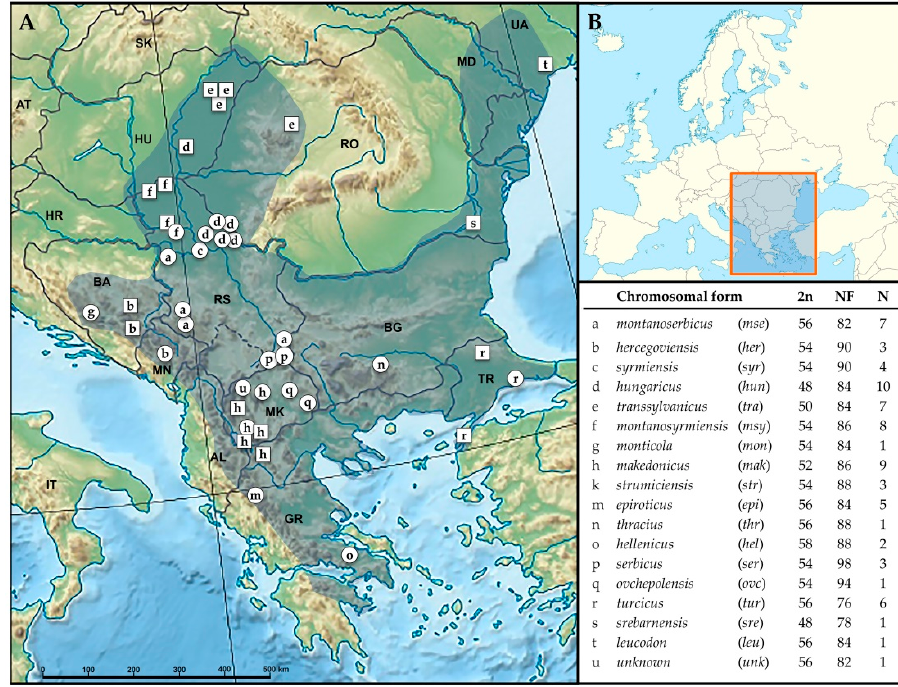
Figure 1. Geographic map with the distributional area of N. leucodon (blue shade): Circles—sampling localities of 40 accomplished sequences (IDs in Table 1); squares—sampling localities of all other imported sequences (IDs in Tables S1 and S2). Letters on the map correspond to chromosomal forms (CFs) listed herein and in Table 1, Table S1, and Table S2. N—total sample size of CFs; 2n—diploid chromosomal numbers; NF—fundamental number of chromosomal arms. ( A )—Relief location map of Europe (source: https://commons.wikimedia.org/wiki/File:Europe_relief_laea_location_map.jpg accessed on 29 March 2022). ( B )—Position of the study area in the European scale (source: https: //d-maps.com/ accessed on 30 March